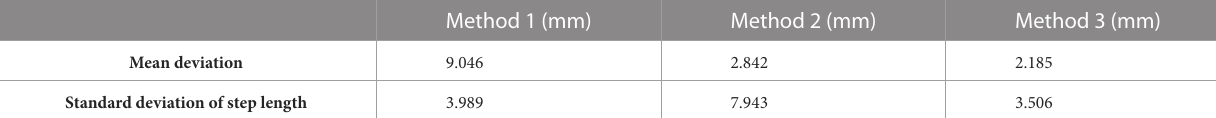
TABLE2 Meandeviationandsteplengthstandarddeviationofthecontactpointestimationusingthreemethods.